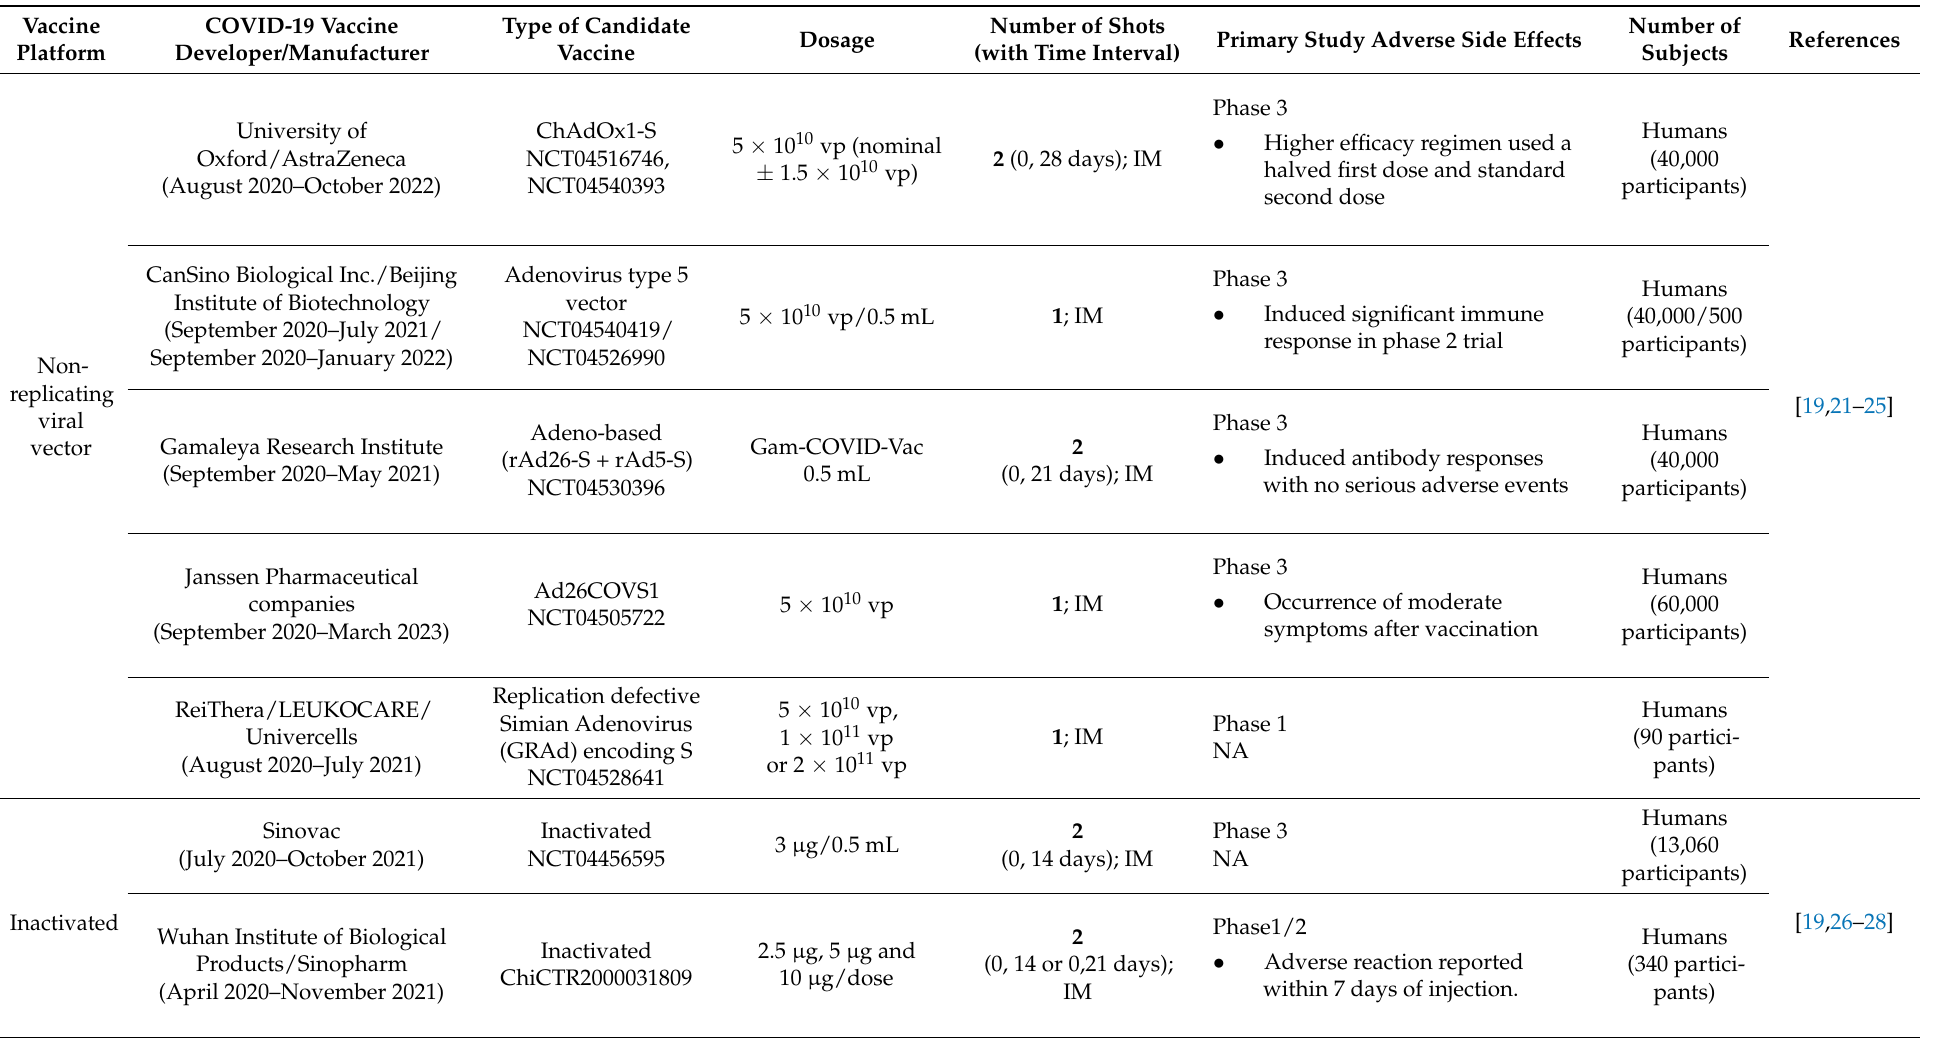
Table 1. List of candidate vaccines for severe acute respiratory syndrome coronavirus 2 (SARS-CoV-2) under clinical